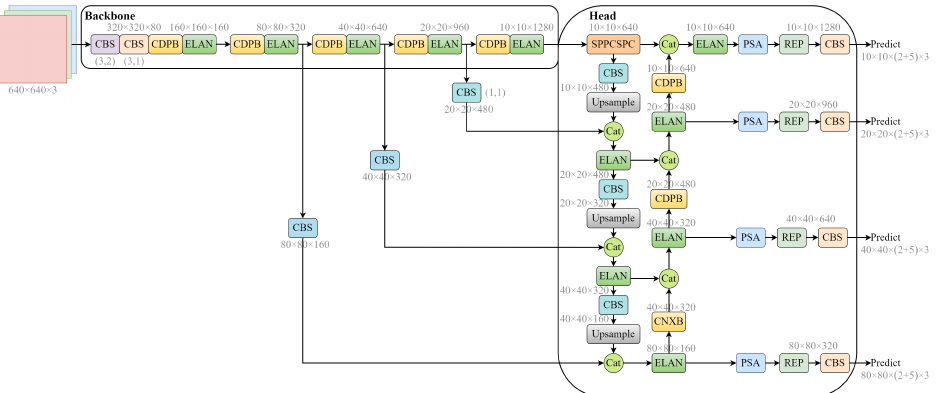
Figure 3. The structure of the improved fire smoke detection model based on